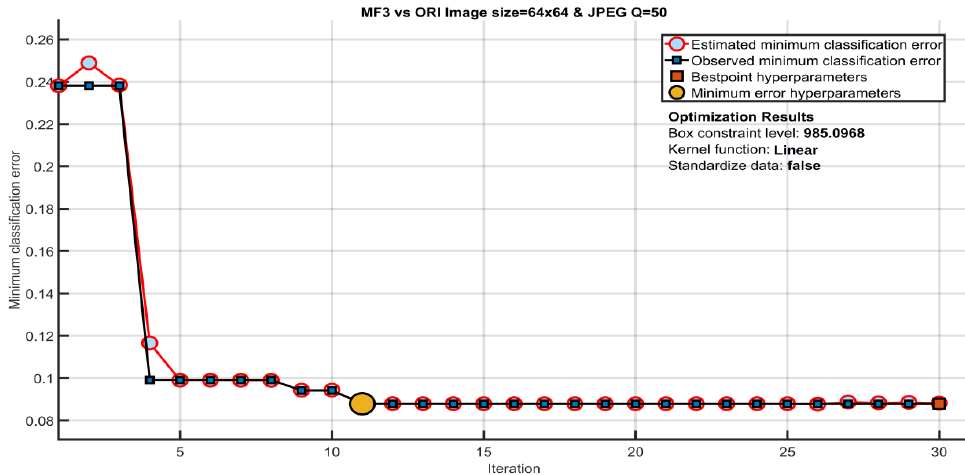
Figure 8. Optimization of the SVM hyper-parameters selection. Experimental results are discussed in two sections. In Section 4.1, results are dis- cussed between non-filtered and filtered images in Tables 1–3 on UCID dataset and in